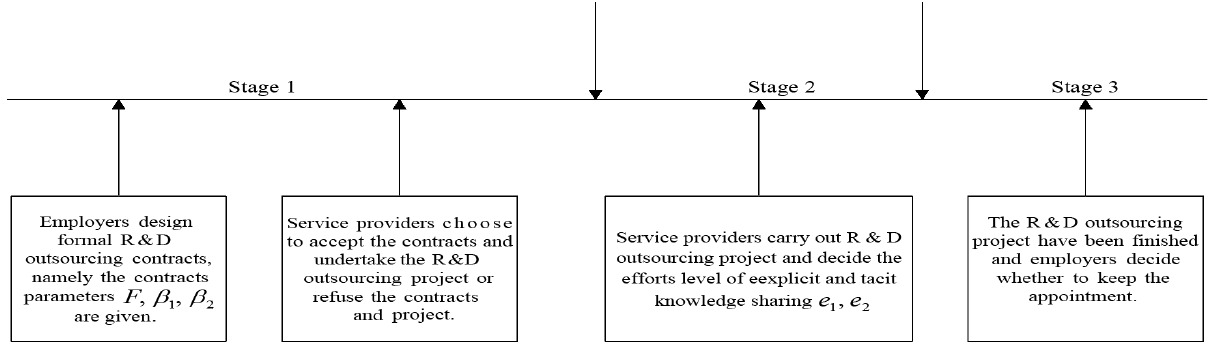
Figure 1. Time Series of the Game of Formal R&D Outsourcing